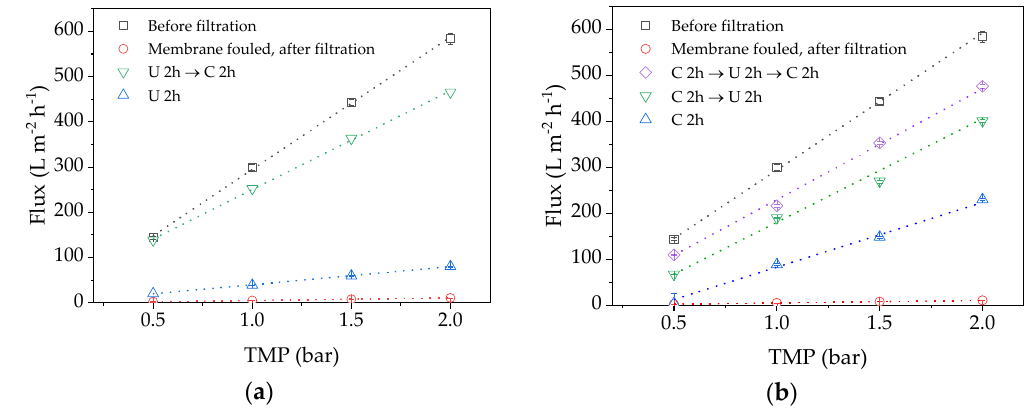
Figure 4. TMP-dependent pure water flux values following different cleaning strategies. ( a ) U 2 h (blue), U 2 h → C 2 h (green); ( b ) C 2 h (blue), C 2 h → U 2 h (green), C 2 h → U 2 h → U 2 h → C 2 h (purple). C = citric acid, U = P3 Ultrasil 14.